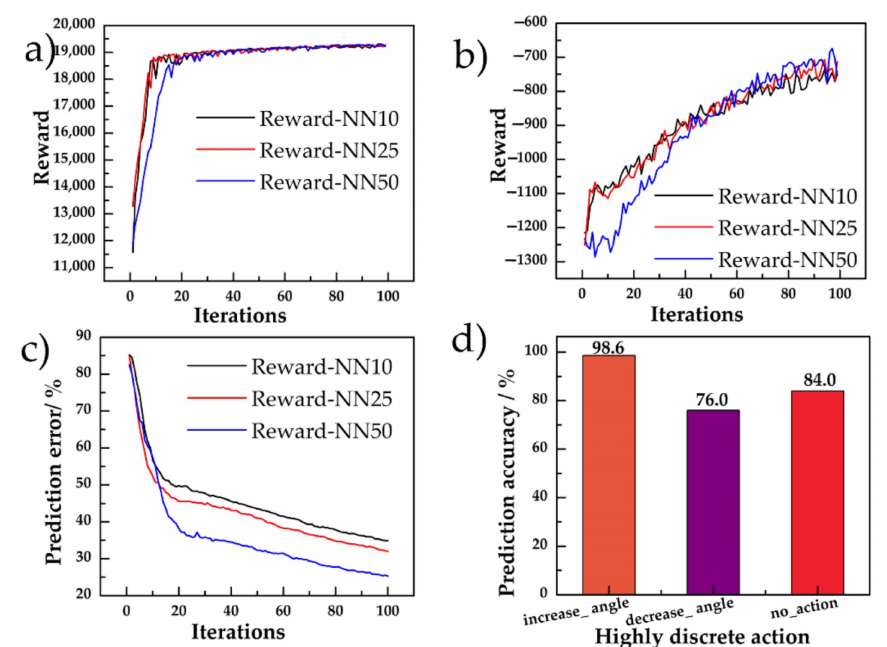
Figure 7. Results of the pre-train model: ( a ) Total reward using di ff erent hidden layer size of the policy networks; ( b ) reward of the steering smooth term Ra defined in Equation (6) for 3 sizes of policy networks; ( c ) steering wheel angle prediction error; and ( d ) fuzzy action prediction accuracy of the selected 25 × 25 hidden layer